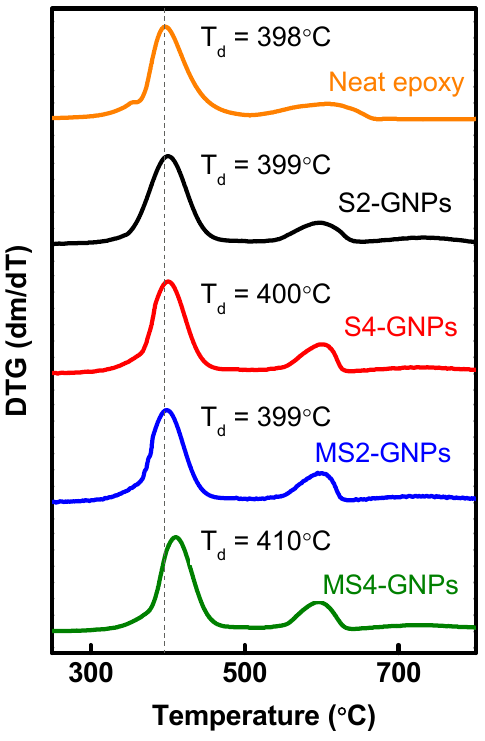
Figure 7. DTG curves of neat epoxy and GNP/epoxy composites loaded with 10 wt.% of S2-, S4, MS2-, and MS4-GNPs.